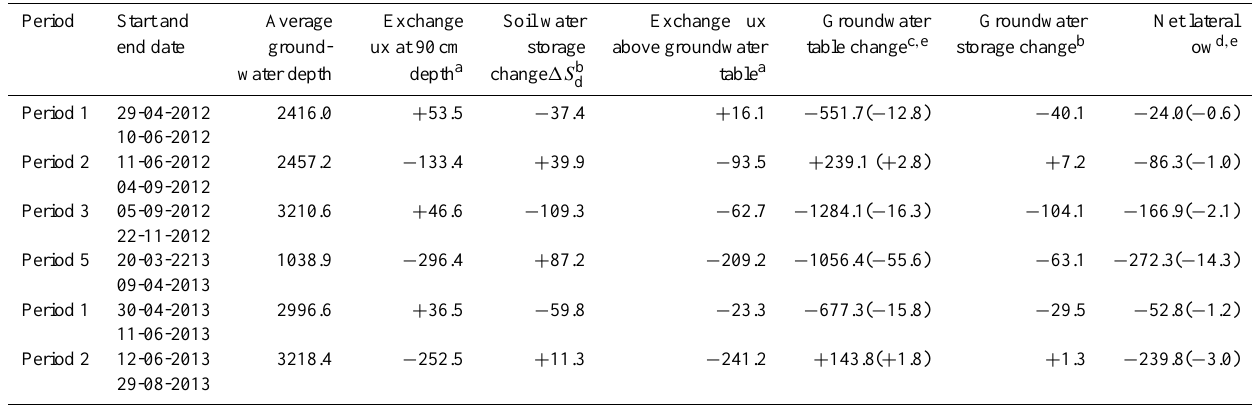
Table 3. Evaluation of groundwater and lateral flow (unit: mm).